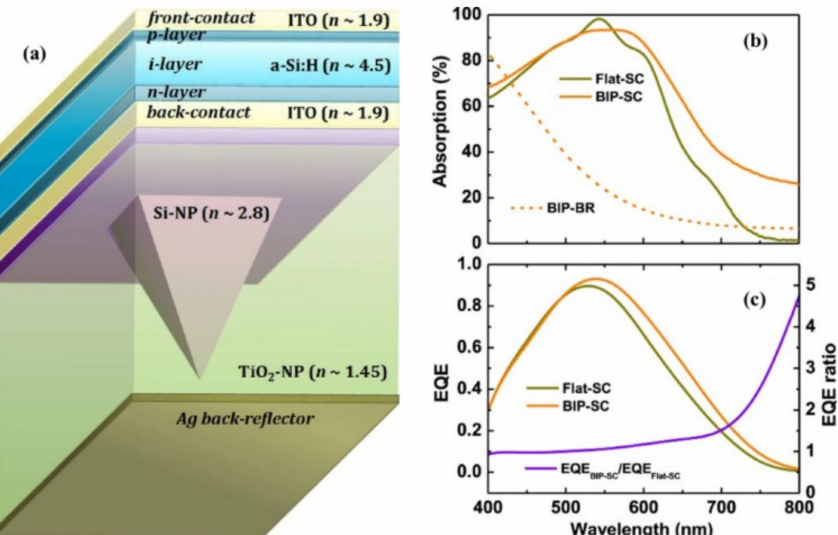
Figure 11. ( a ) Schematic illustration of a BLiS back reflector for n–i–p Si thin-film solar cells. The TiO 2 -NP layer over the planar silver back reflector had inverted pyramid-shaped microcavities, which were further covered by a flat-topped Si-NP layer. ( b ) Total optical absorption by Flat-SC and BIP-SC devices (solid lines) and parasitic absorption by the BIP-BR (dashed line). ( c ) Measured EQE (left-hand side y -axis) spectra of Flat-SC and BIP-SC devices and EQE ratio (right-hand side y -axis) [173]. Reprinted with permission from [173], 2020, Creative Commons Attribution License (https://creativecommons.org/licenses/by/4.0, accessed on 4 February 2020).